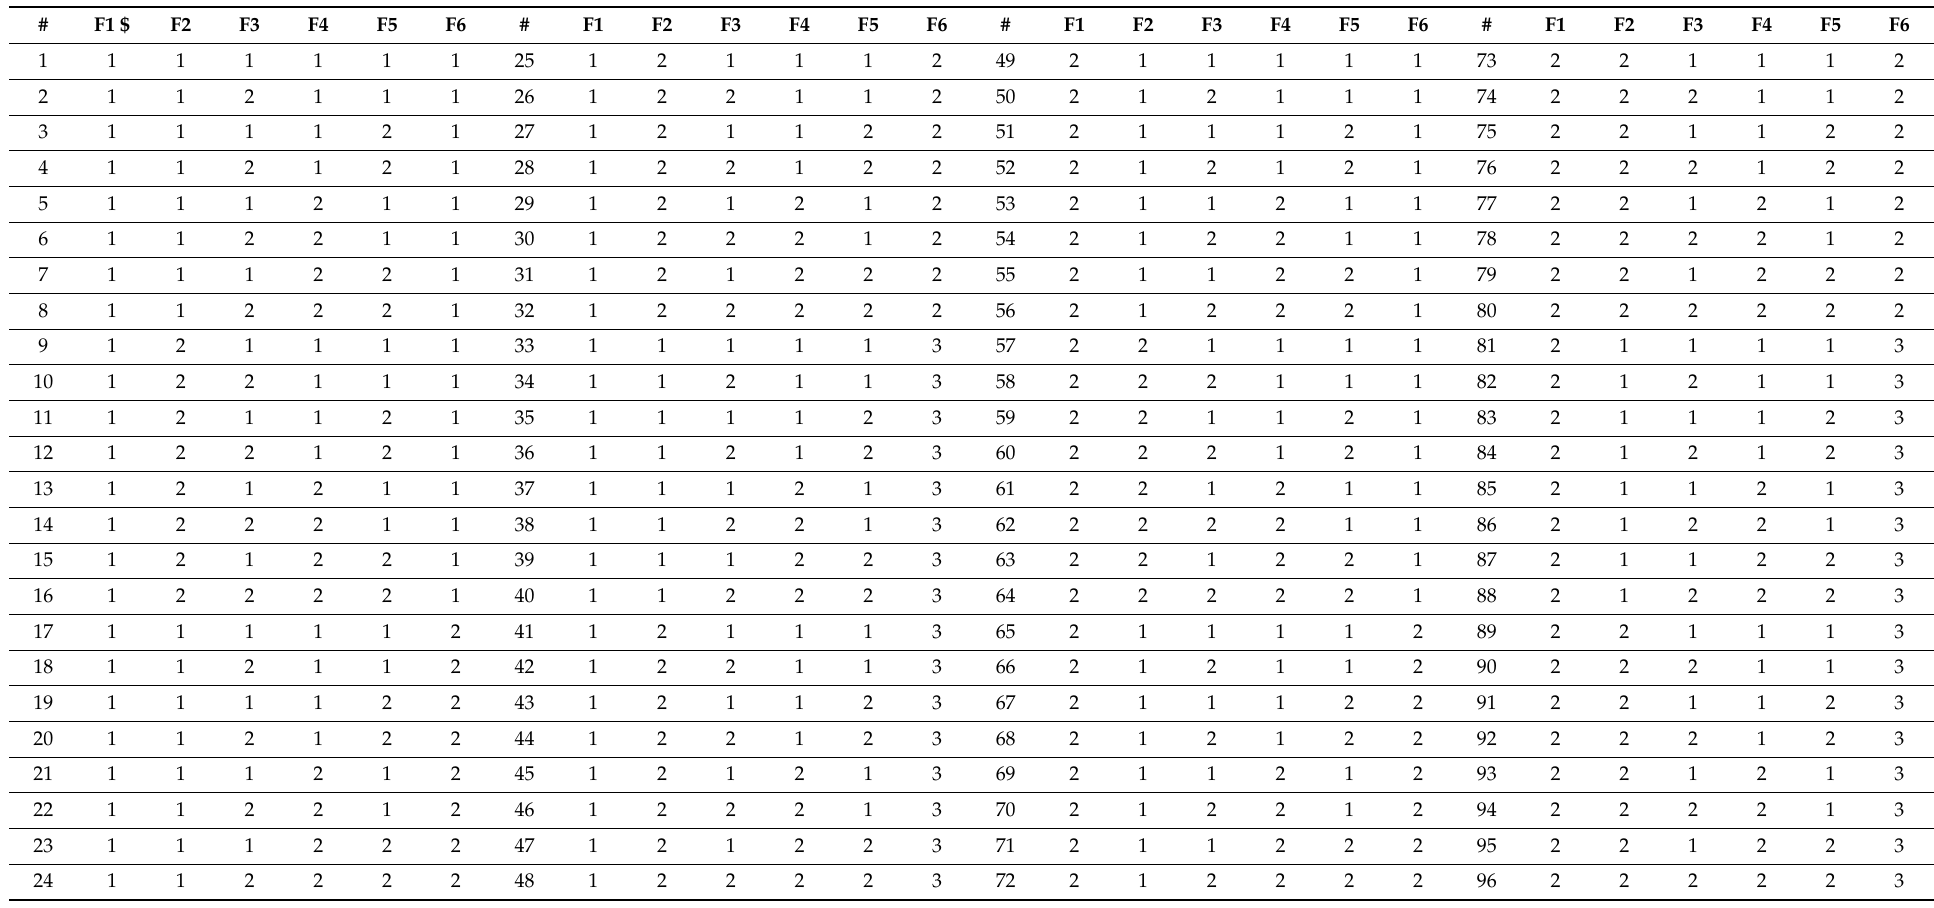
Table A2. Full factorial experimental